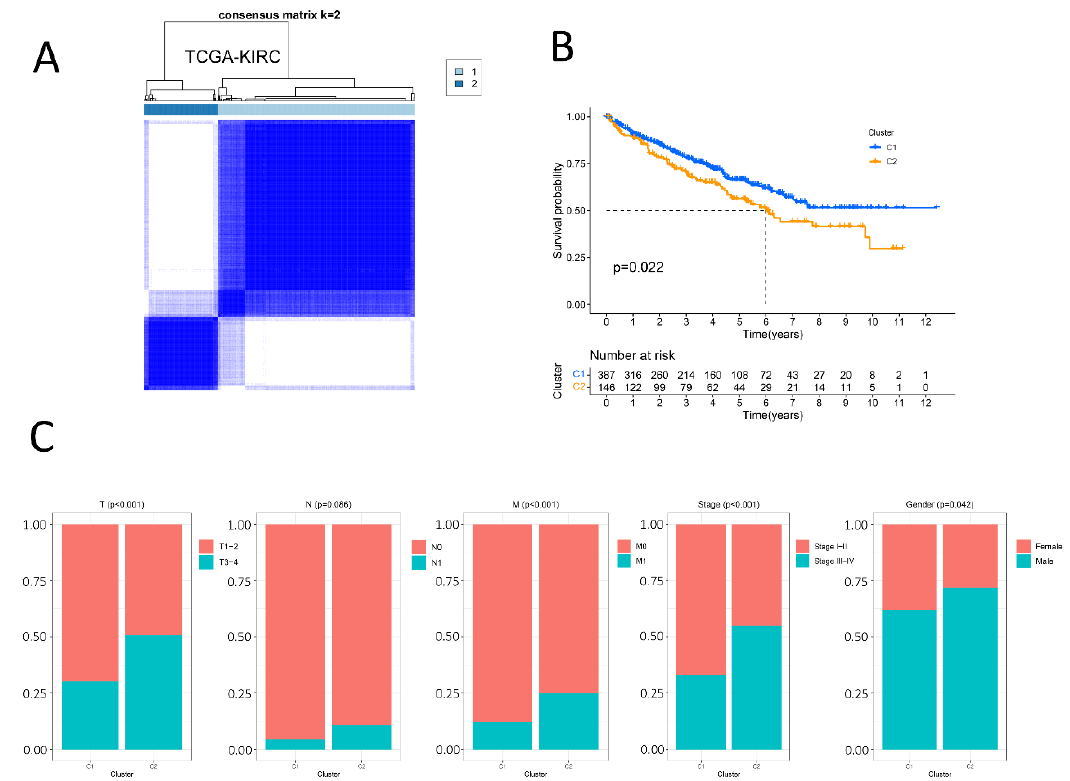
Figure 3. Identification of two heterogeneous molecular clusters with distinct clinical features by consensus clustering analysis. ( A ): Consistent clustering is performed in The Cancer Genome Atlas- Kidney renal clear cell carcinoma (TCGA-KIRC) cohort and two clusters are obtained. Two clearly delimited blue squares represent different molecular subtypes. ( B ): Kaplan – Meier survival plot of the two clusters in the TCGA-KIRC cohort. The blue color indicates cluster 1, and the orange represents cluster 2 ( C ): The proportion of clinicopathologic features (T, N, M, stage, gender) of the two subtypes. There exist significant differences, except for the N stage ( p = 0.086), between the two clusters. p < 0.05 was considered to be statistically significant.